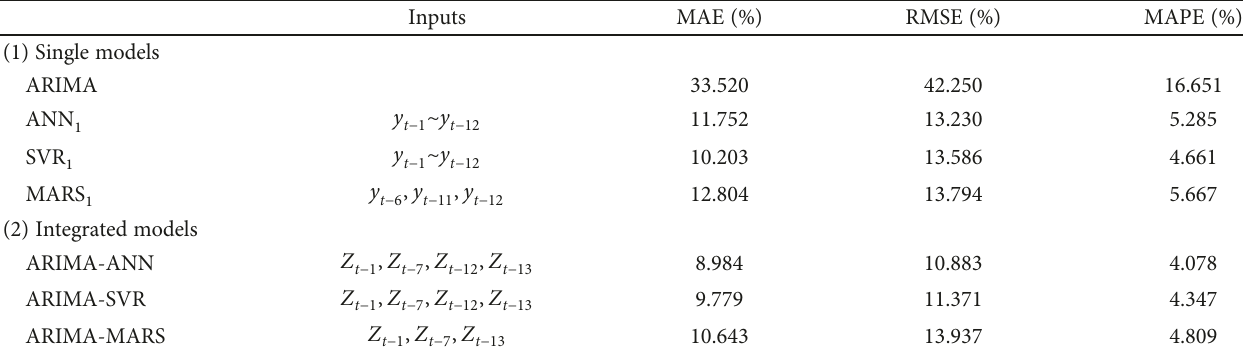
Table 17: Performance comparison of various models for wheat price forecasting.